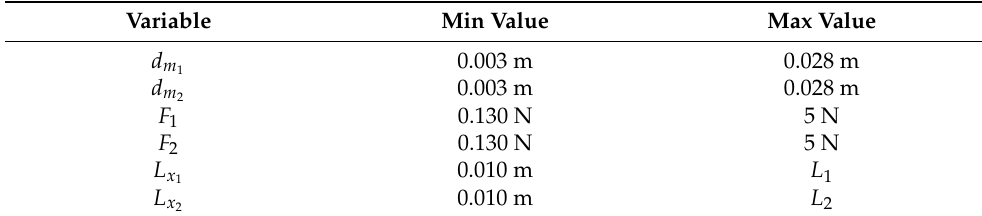
Table 3. Design parameters by integration of the magnetic spring system in the robot.